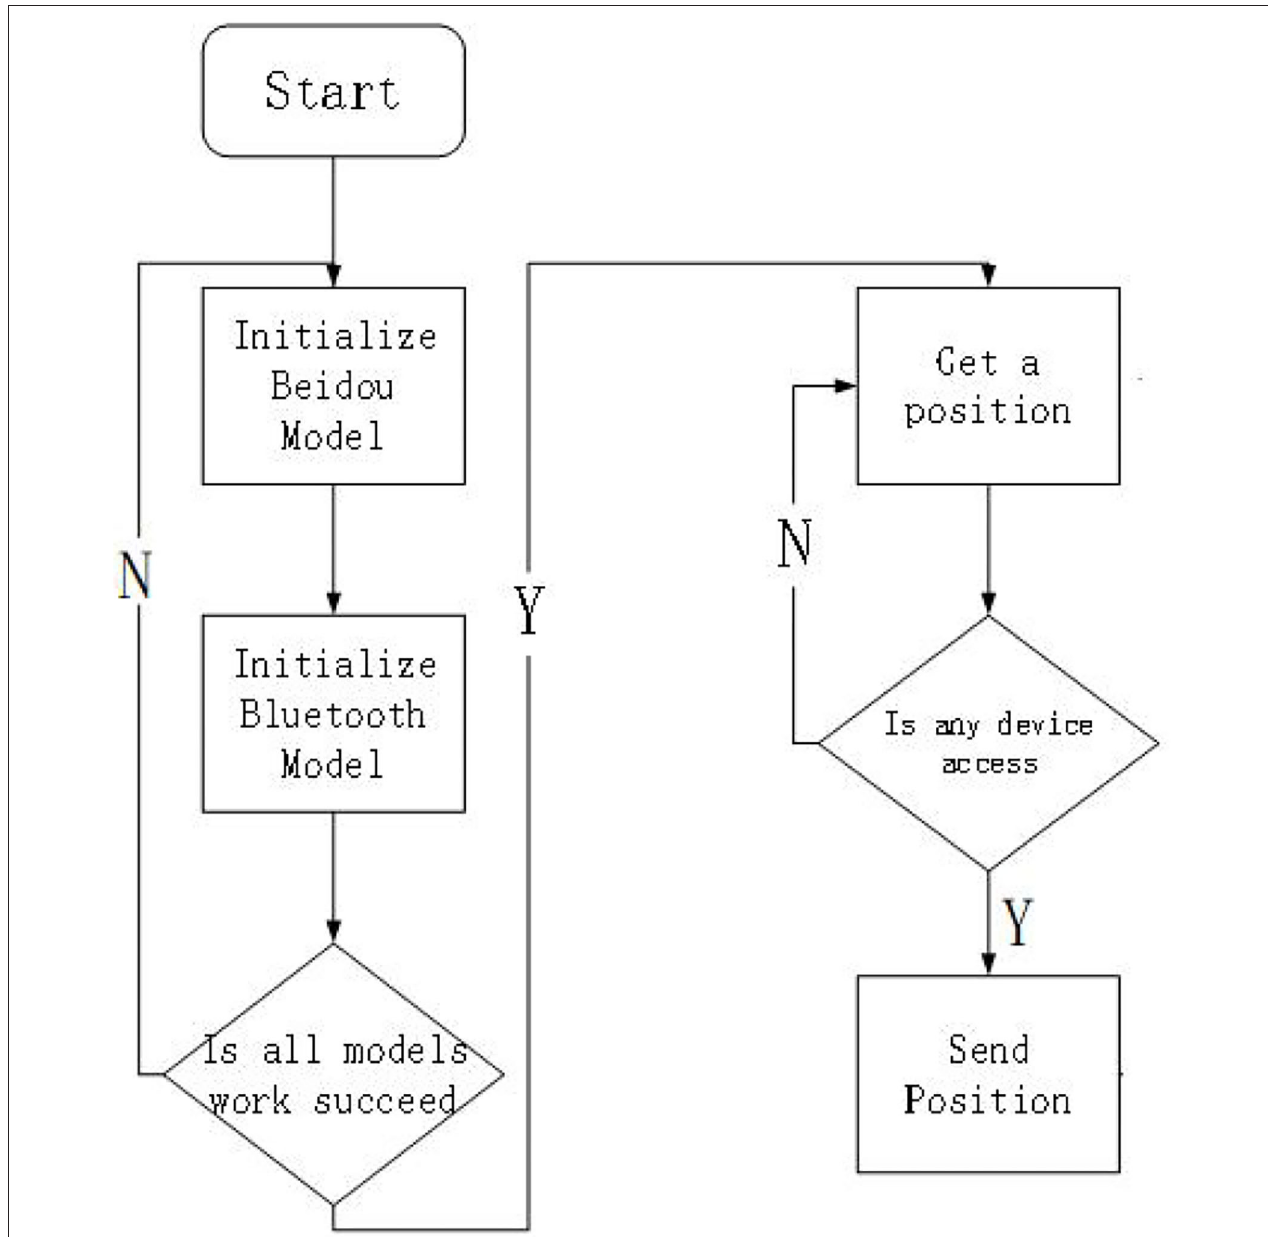
FIGURE 2 | Beidou terminal system design